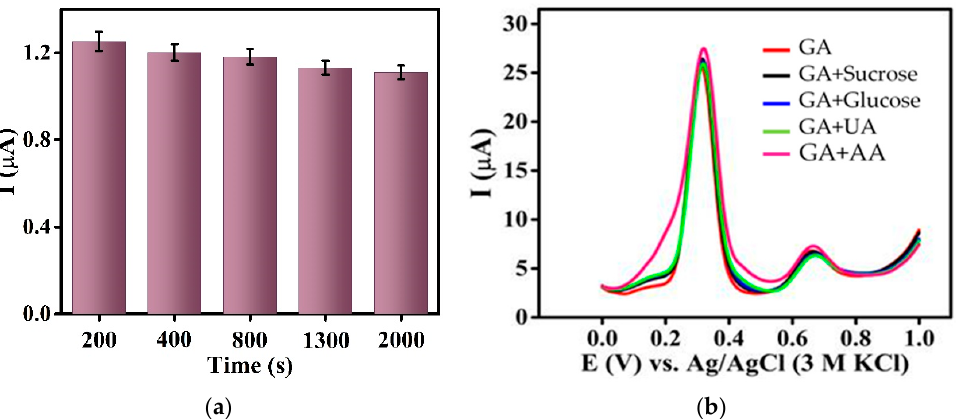
Figure 8. ( a ) Stability for long-term testing. ( b ) Interference test of 60 µ M GA with 0.6 mM of some known interfering species.